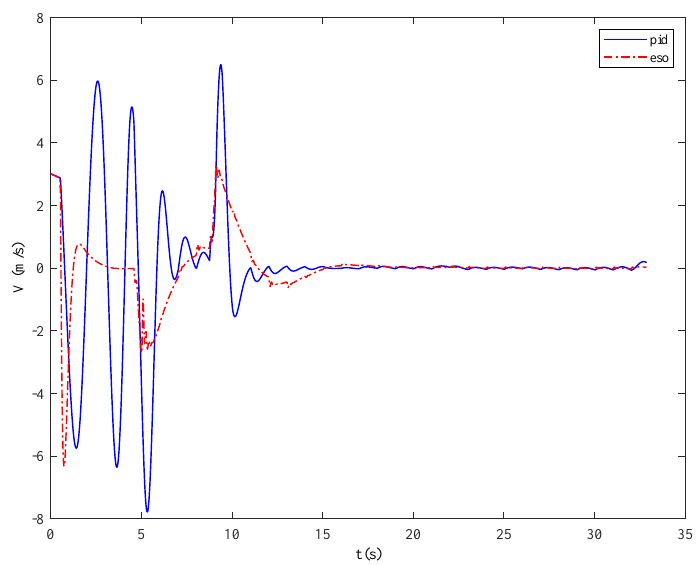
Figure 14. Comparison of roll angle speed change curve between PID and the controller.